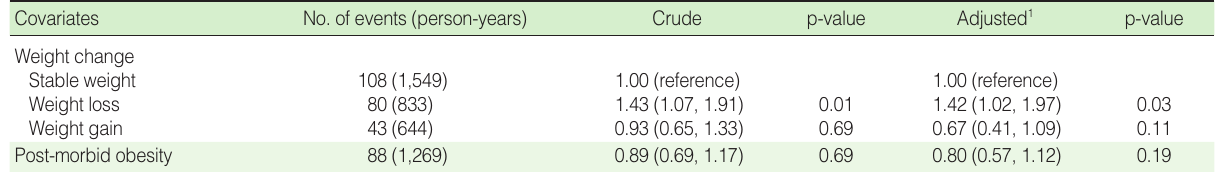
Table 4. Crude and multivariate adjusted model for the effect of post-morbid obesity on all-cause mortality, adjusting for weight change and other pre-morbid and post-morbid covariates